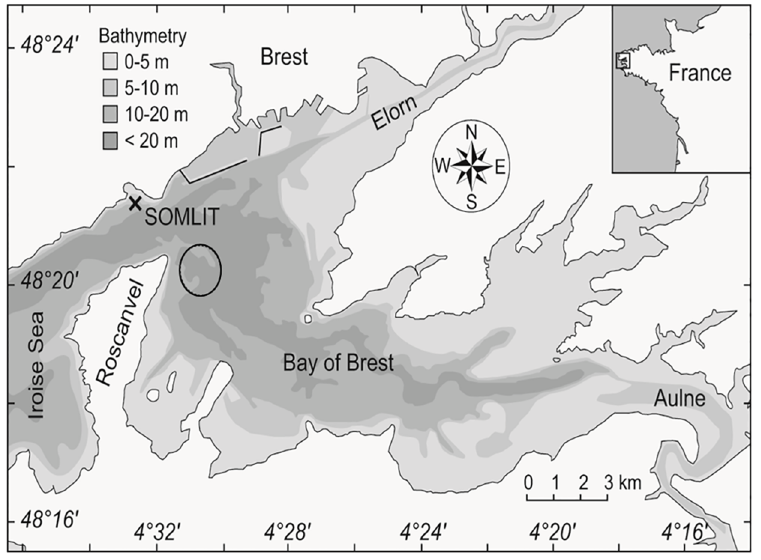
Fig 1. Location of Brittany in France and sample location within Brittany. Circle indicatessample site and ‘X’ shows the position of SOMLIT-Brest researchstation. Adapted from The´bault & Chavaud[42].